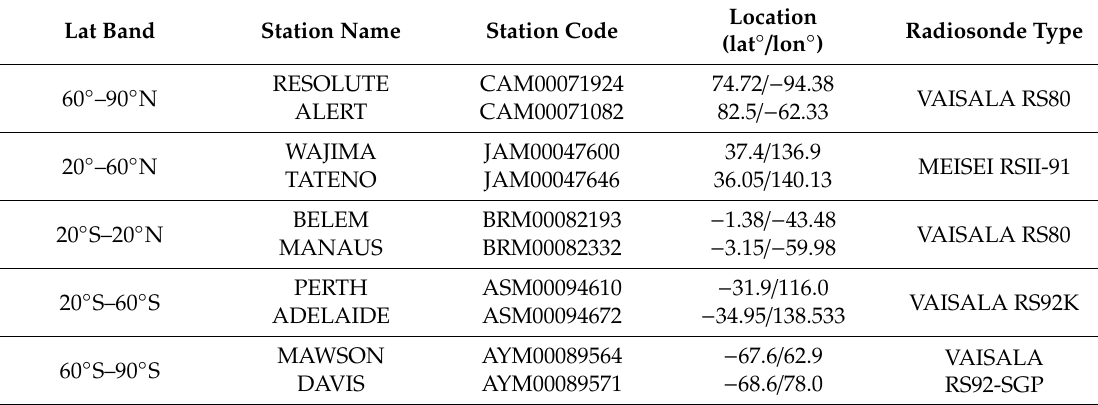
Figure 1. Locations of the 10 selected radiosonde stations from IGRA2. Table 1. Detail information of selected IGRA RS stations for comparison, the final five digital numbers of the station code are the WMO identification number of each station.